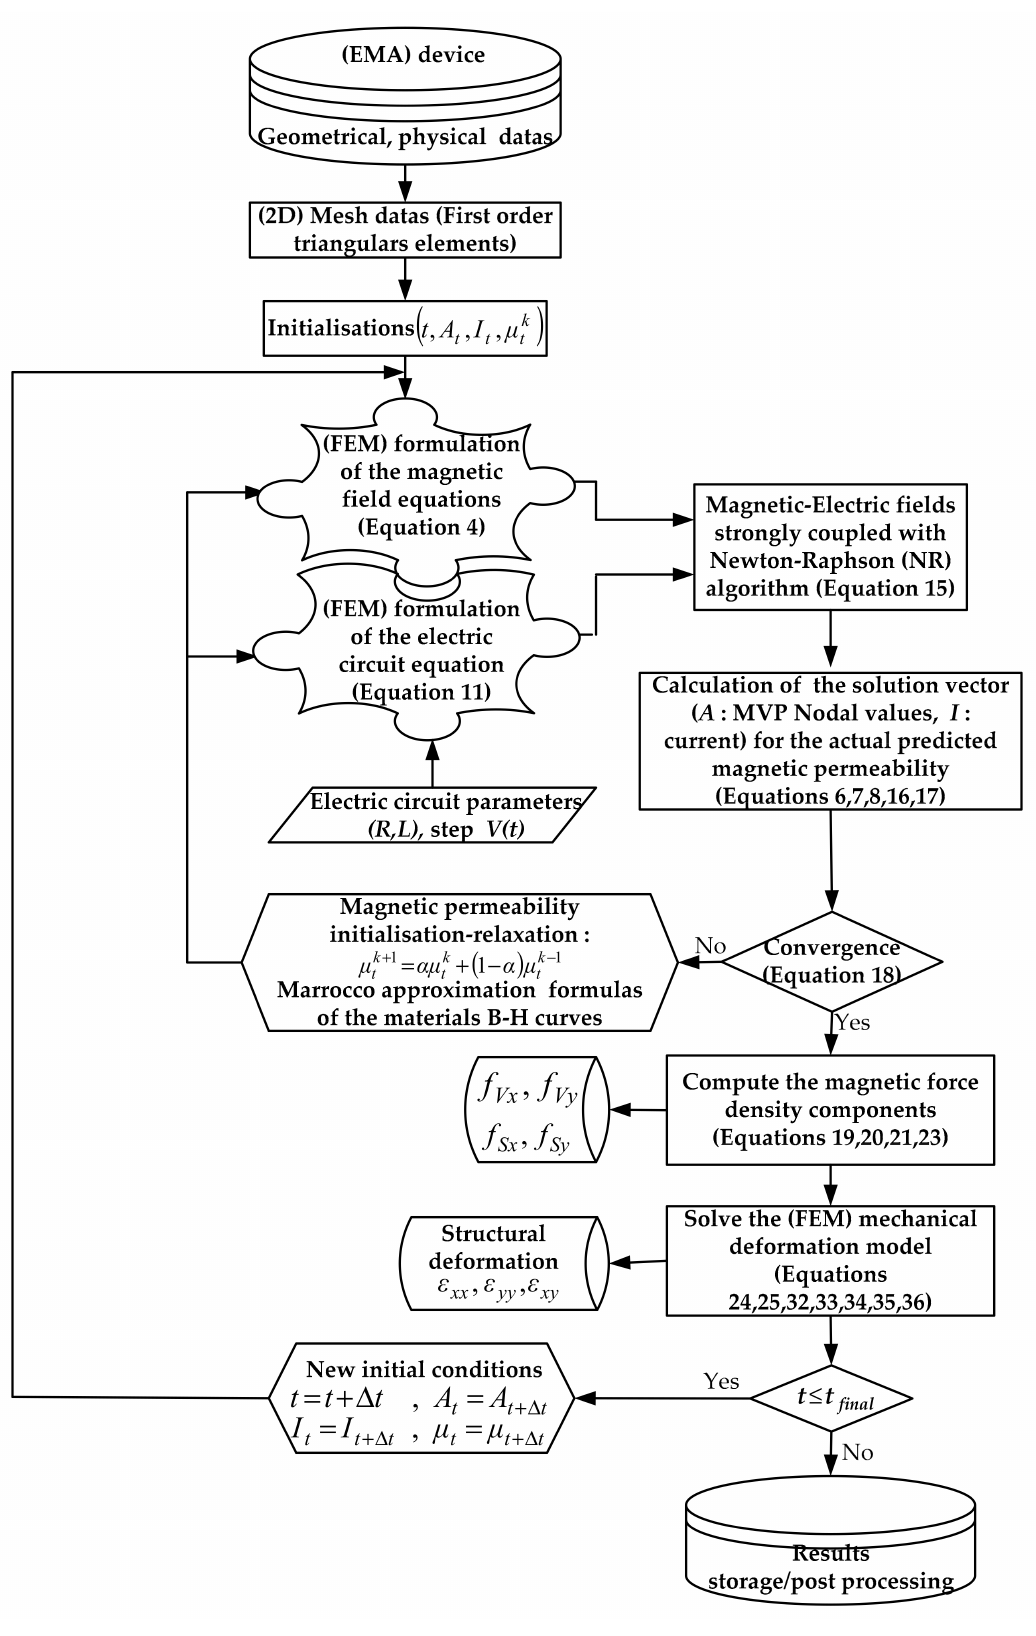
Figure 1. Flowchart of the magnetic field–electric circuit and structural mechanical multi-physical